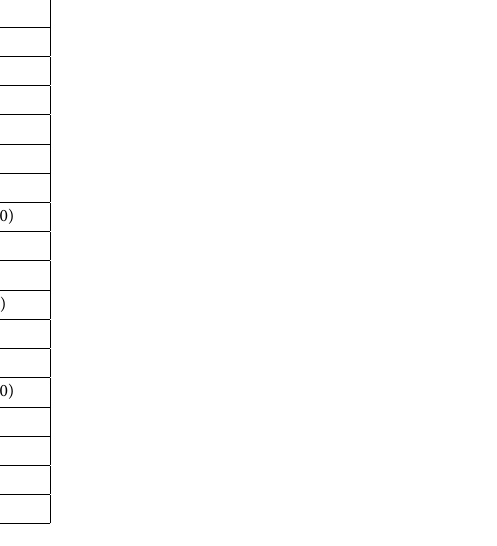
Table 1. Demographic and morphometric